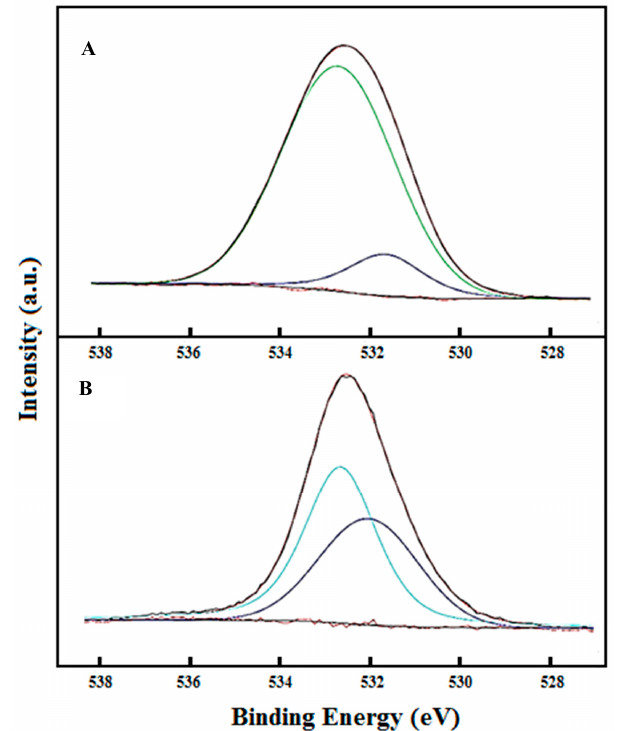
Figure 5. High-resolution XPS spectra of the O 1 s region of MTX in β -CD/MTX ( A ) and AuNPs + β -CD/MTX ( B ). The measured spectrum (black line) and the fitting curves (blue light and blue dark lines) are also depicted.